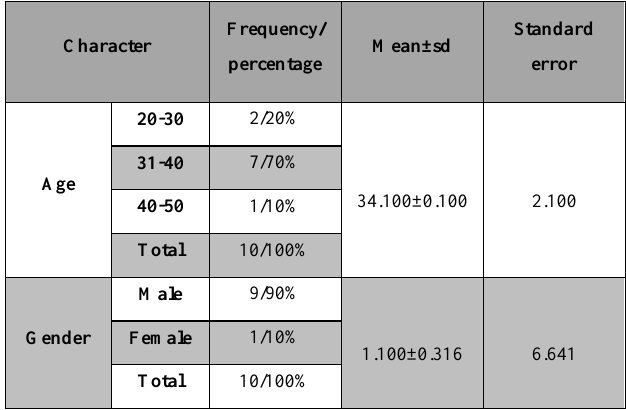
Table 1. Representing the general characteristics of the study